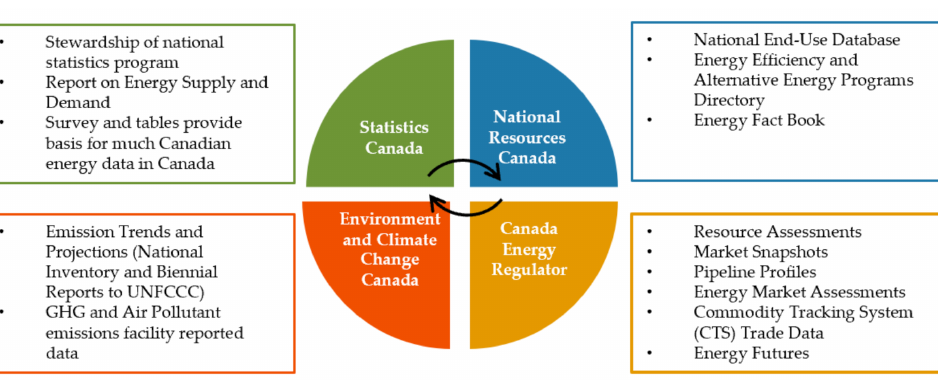
Figure 4. Canada’s Federal Energy Information Framework